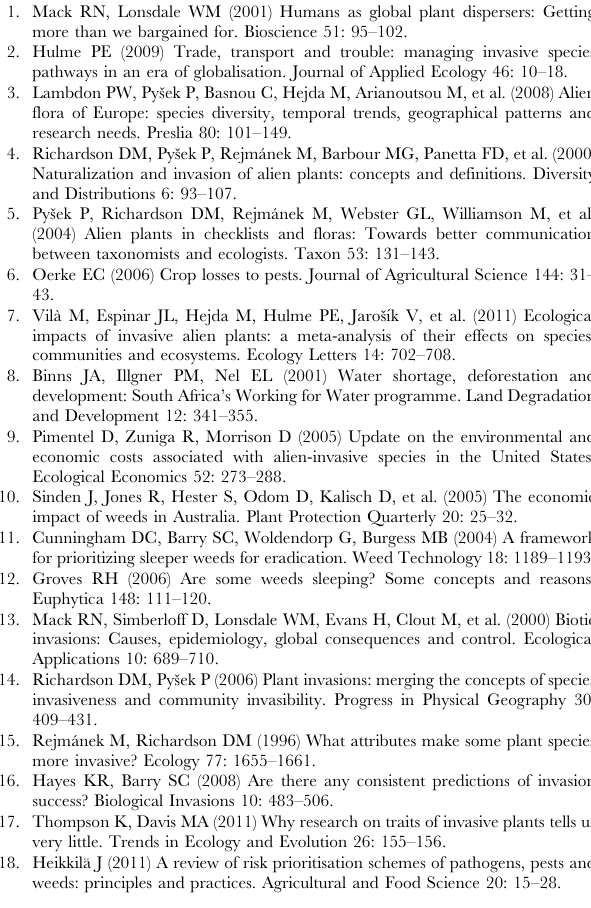
Table S2 Regions comprised in the final dataset analysed. Table S3 SOM indices of plant taxa in each state (except Tasmania) and the Northern Territory that are current- ly absent from Australia, but have the highest likelihood of becoming weeds if introduced. Table S4 SOM indices of plant taxa in each state (except Tasmania) and the Northern Territory that are present in Australia, but not currently recorded as weeds in the particular state/territory and have the highest likeli- hood of becoming one in the